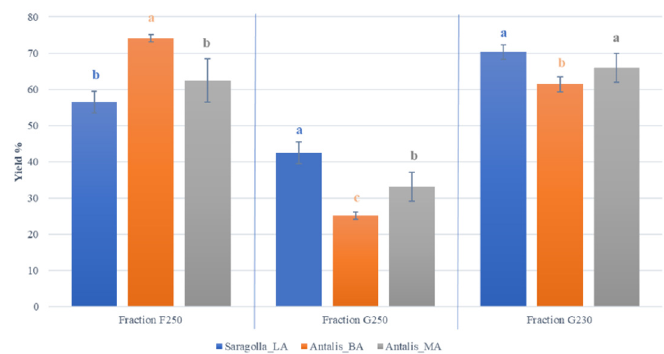
Figure 2. Mean yield (%) of F250, G250 and G230 air-classified fractions obtained from Saragolla_LA, Antalis_BA and Antalis_MA samples. Different letters indicate statistically significant differences ( p < 0.05, n = 3) within each fraction type. F250: Saragolla_LA = 3.4 kg, Antalis_BA = 4.5